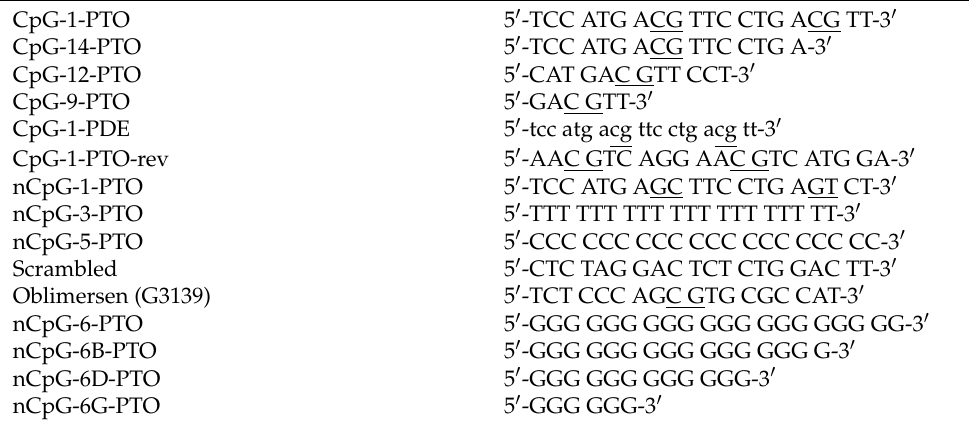
Table 1. Oligonucleotides. Phosphorothioates (PTOs) are in capital letters, phosphodiesters (PDEs) are in small letters and CpG motifs are